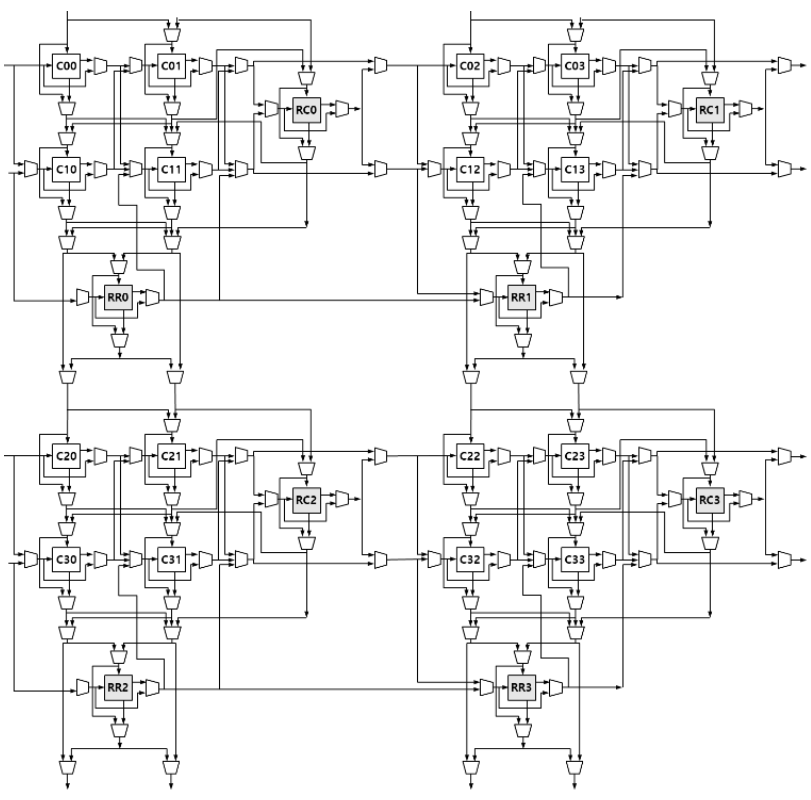
Figure 7. Proposed redundancy architecture with PL : 4 and OL : 2.